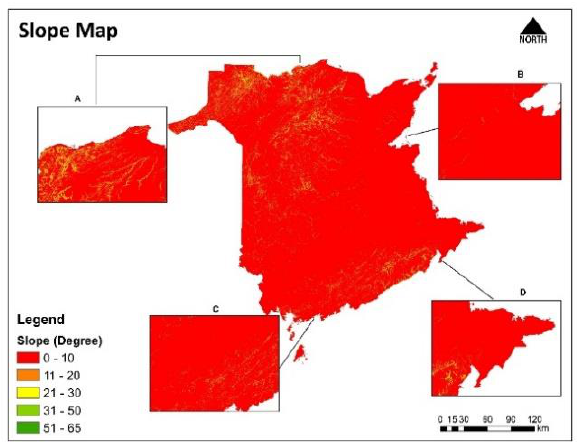
Geosciences 2020 , 10 , x FOR PEER REVIEW